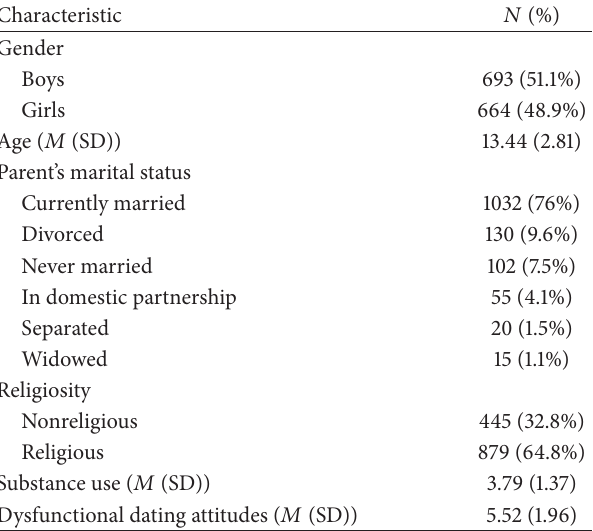
Table 1: Participant characteristics ( 𝑁 = 1357). Table 2: Correlations among participant age, gender, dysfunctional dating attitudes, religiosity, and substance use.